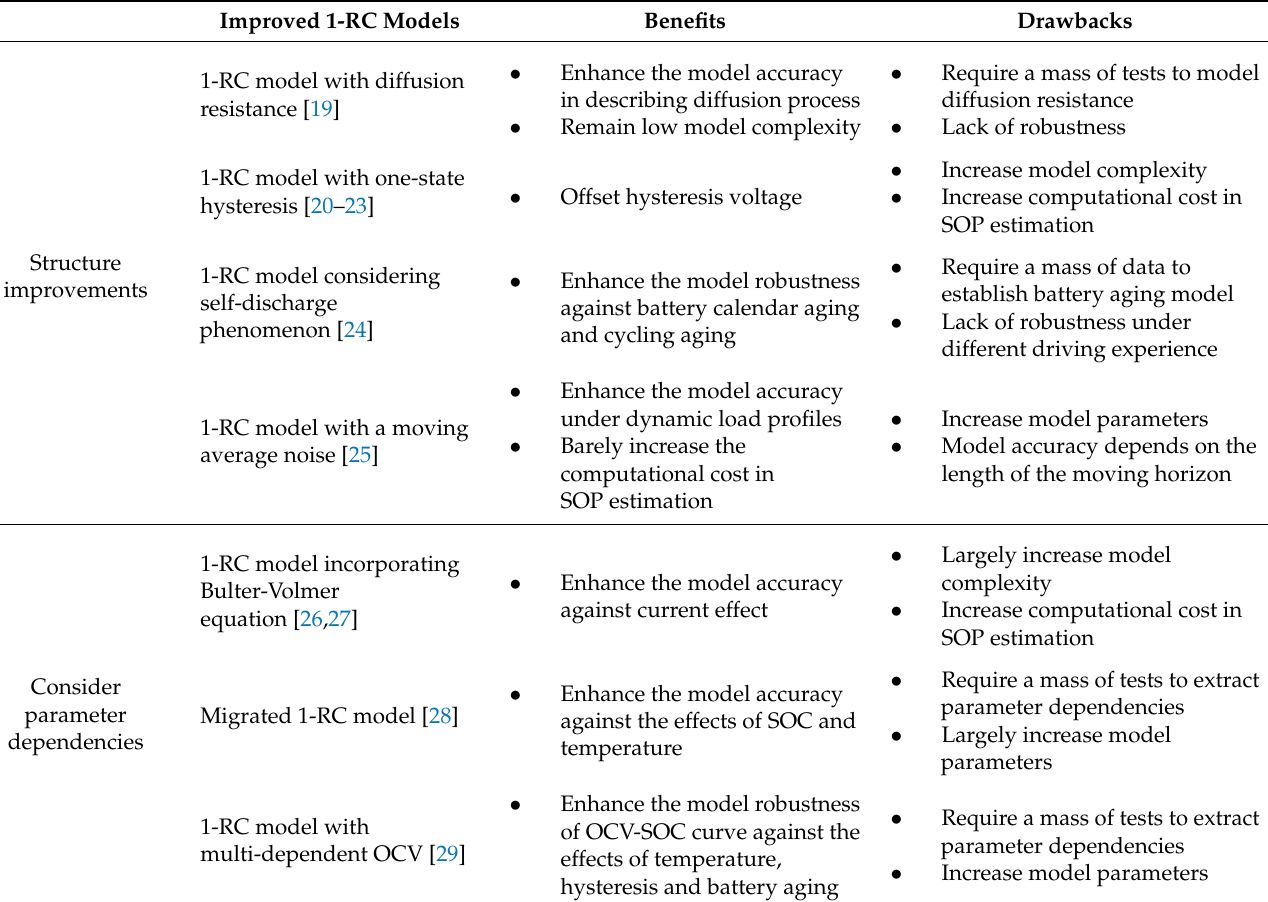
Table 1. Benefits and drawbacks of the improved 1-RC models in online SOP